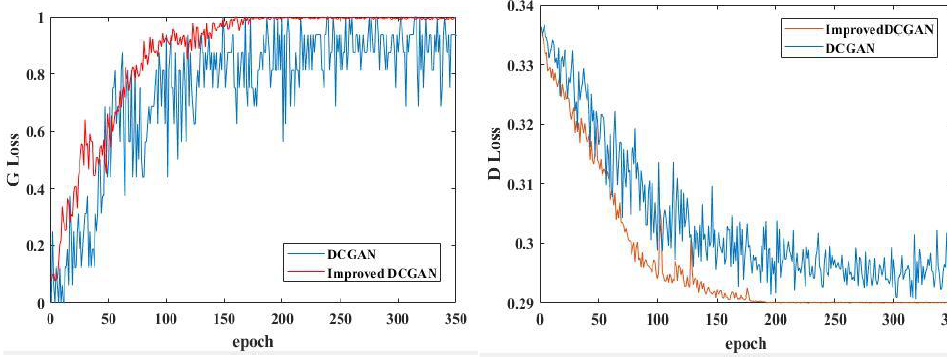
Figure 13. Loss function of generator and discriminator.